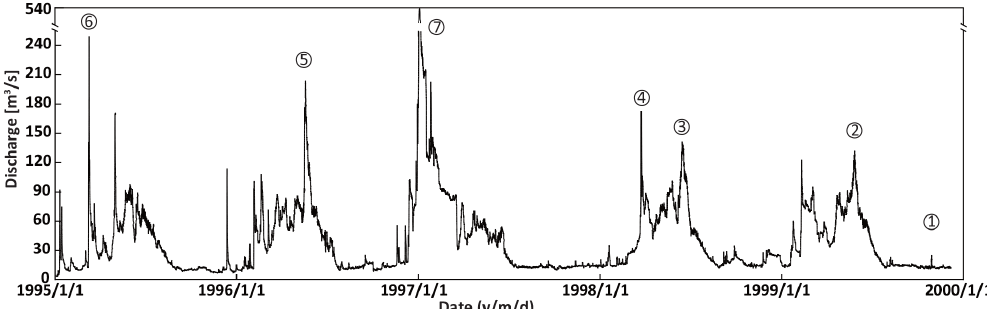
Figure 5. Scenarios of flood events. Cases 6 and 7 represent the 10 and 50 year flood events, respectively.